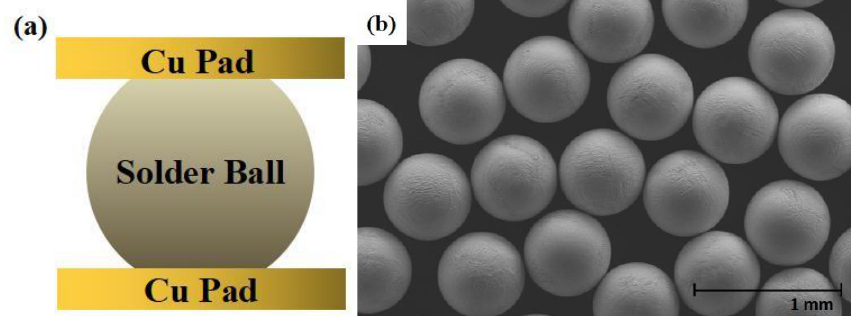
Figure 1. ( a ) Schematic diagram of the solder joint and ( b ) SEM photo of solder balls.